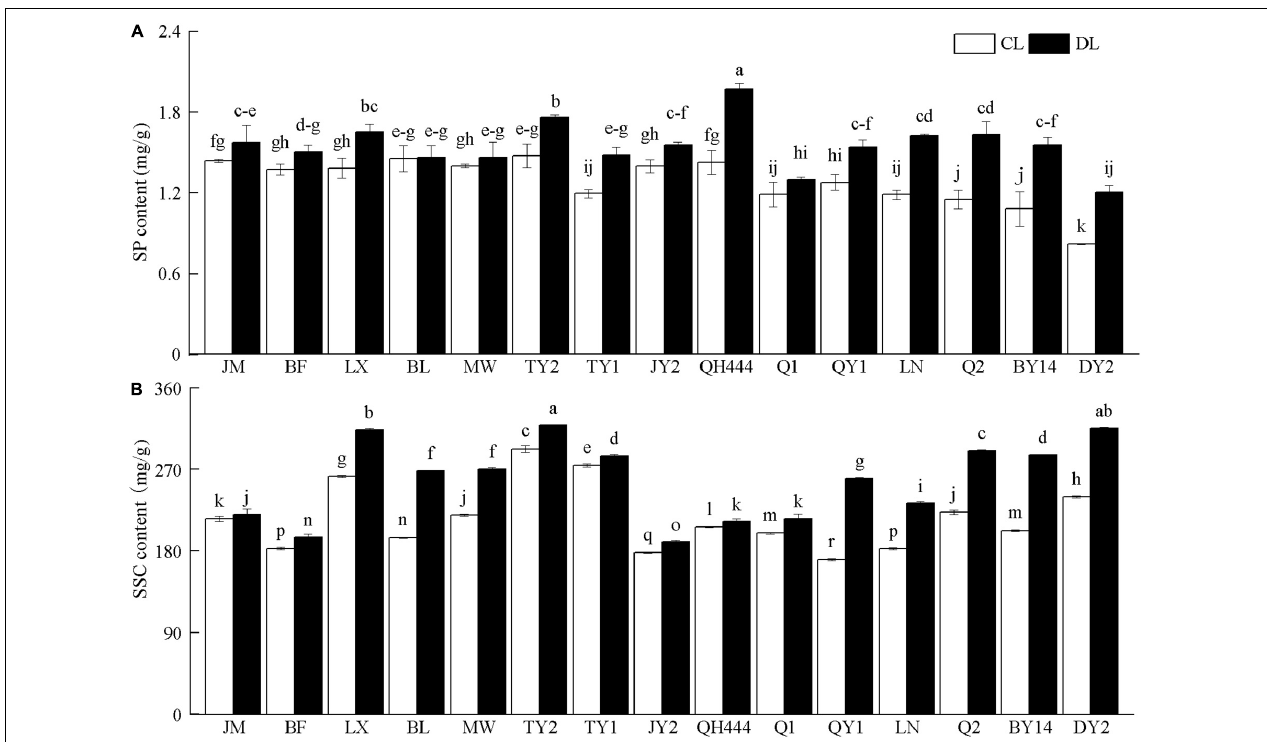
FIGURE 2 | Effects of soluble protein (SP) (A) and soluble sugar (SSC) content (B) in leaves of different oat varieties under drought stress. Each value represents the mean ± standard deviation. Each experiment was repeated three times. An analysis of variance test was performed, followed by Tukey test. CL, untreated control; DL, drought stress. Different letters indicate that the differences between treatments were significant ( P <